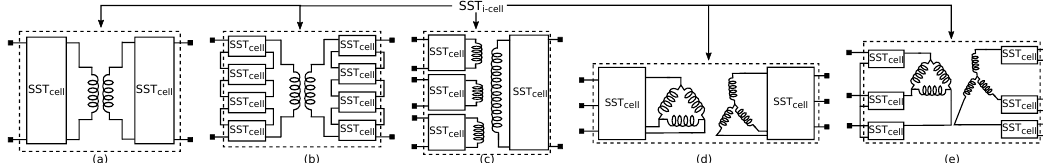
Figure 8. MFT configurations used in SST: ( a ) single phase transformer [4], ( b ) three phase transformer [49], ( c ) single phase multi-winding transformer [55], ( d ) three phase multi-winding transformer [56], ( e ) split winding transformer [57], and ( f ) scott transformer [16].